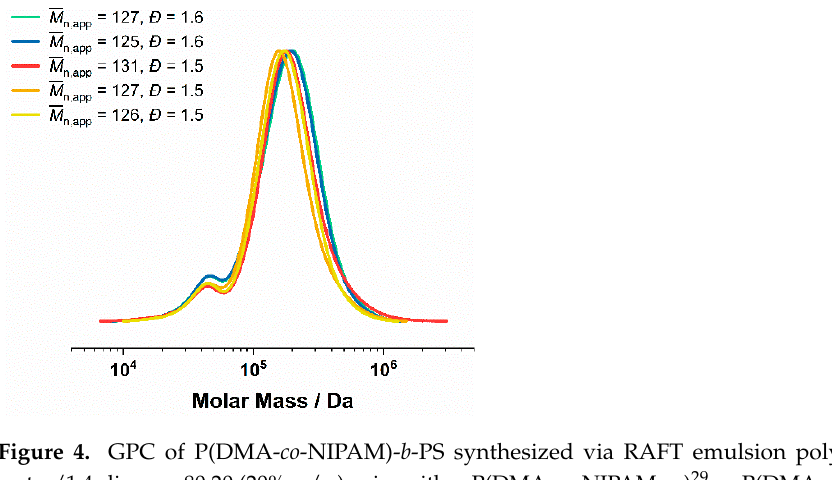
Figure 5. GPC of P(DMA- co -NIPAM)- b -PS synthesized via RAFT emulsion polymerization in water/1,4-dioxane 80:20 (20% w/w ) using either the P(DMA 29 -NIPAM 180 ) 24 or P(DMA 35 -NIPAM 212 ) 28 as mCTA. The 𝑀(cid:3365) (cid:2924),(cid:2911)(cid:2926)(cid:2926) (determined by DMAc GPC calibrated with PS standards) and the dispersity of the respective GPC curve are shown in the legend.